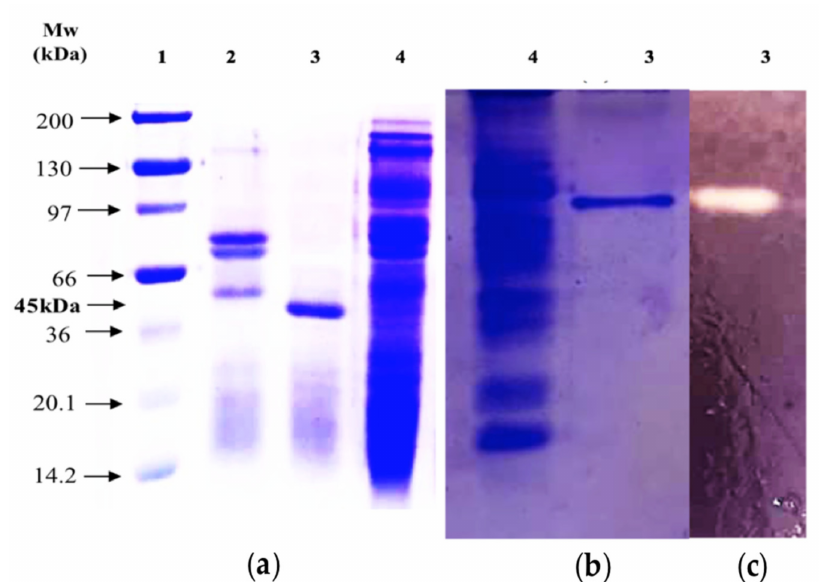
Figure 2. SDS-PAGE ( a ), Native PAGE ( b ) and zymogram detection of amylolytic activity ( c ) of the purified BCA from the blue crab viscera. Lane 1, standard proteins marker; lane 2, G-100 purified; lane 3, Mono Q-purified BCA; and lane 4, visceral